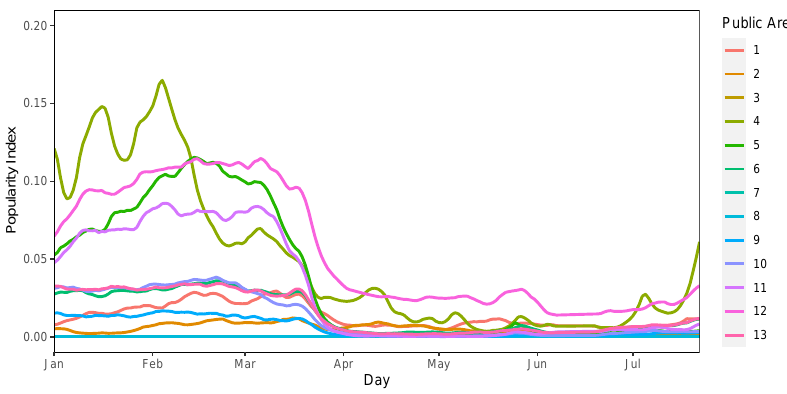
Figure 7. PI trend of public places at Il Paese Ritrovato (January–June 2020).